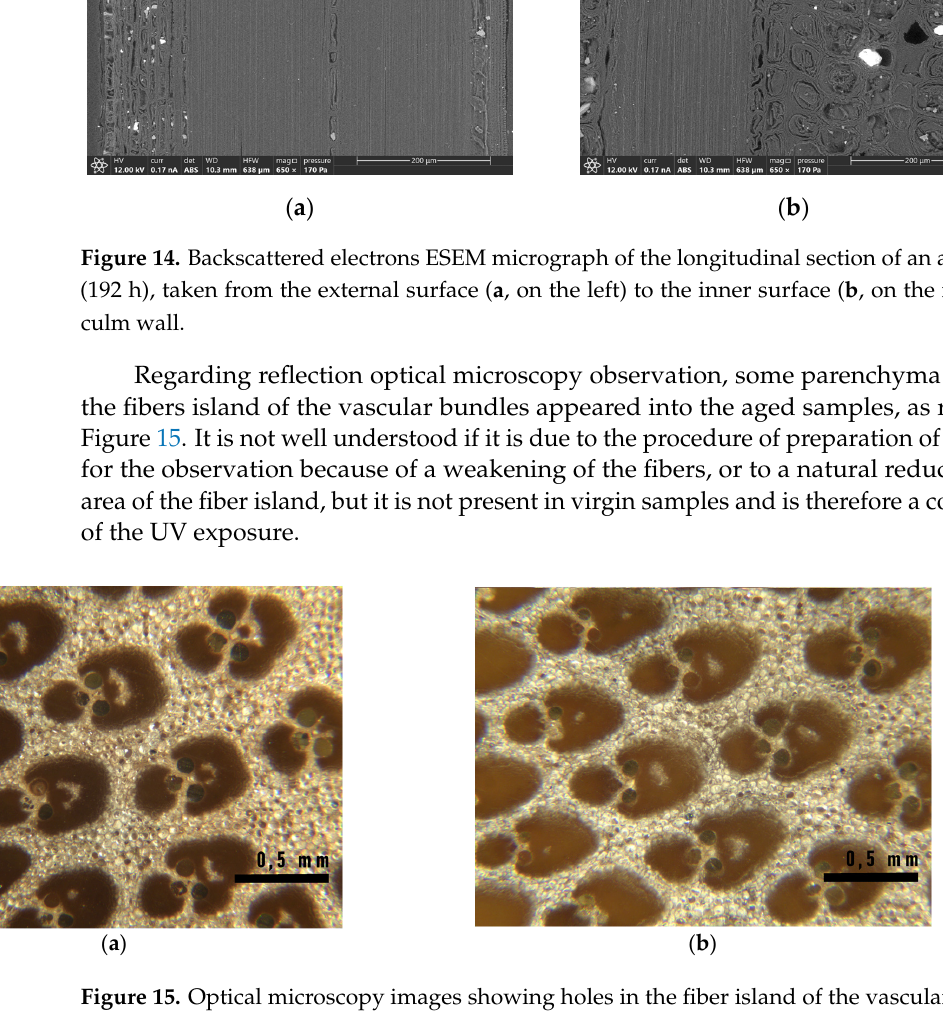
Figure 13. Secondary electrons ESEM images of the border between fibers and ground parenchyma of unaged ( a ) and UV (192 h) aged ( b ) samples, both collected from a vascular bundle of the central part of the culm wall.